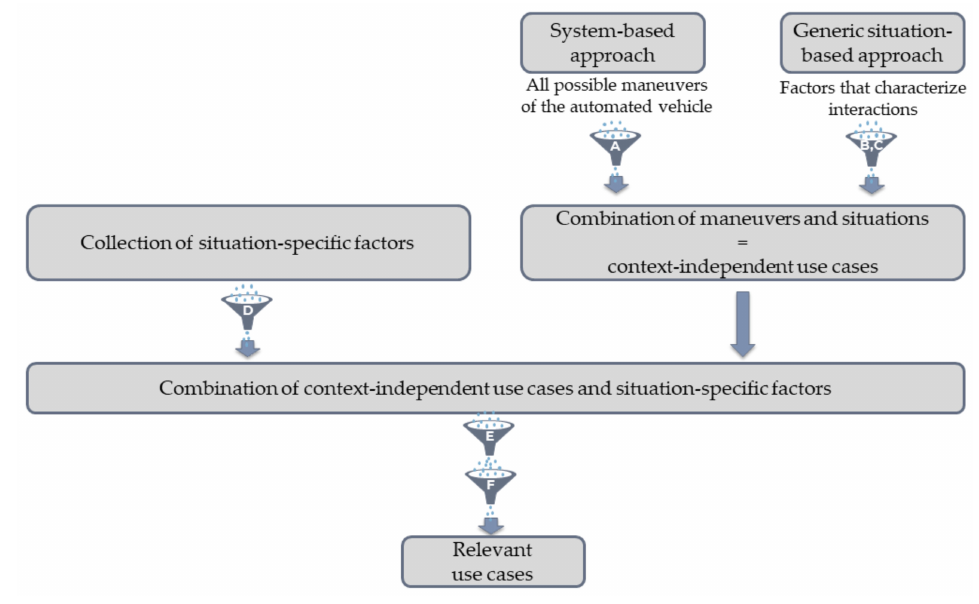
Figure 1. Overview of the methodological approach to select relevant use cases of an external human–machine interface